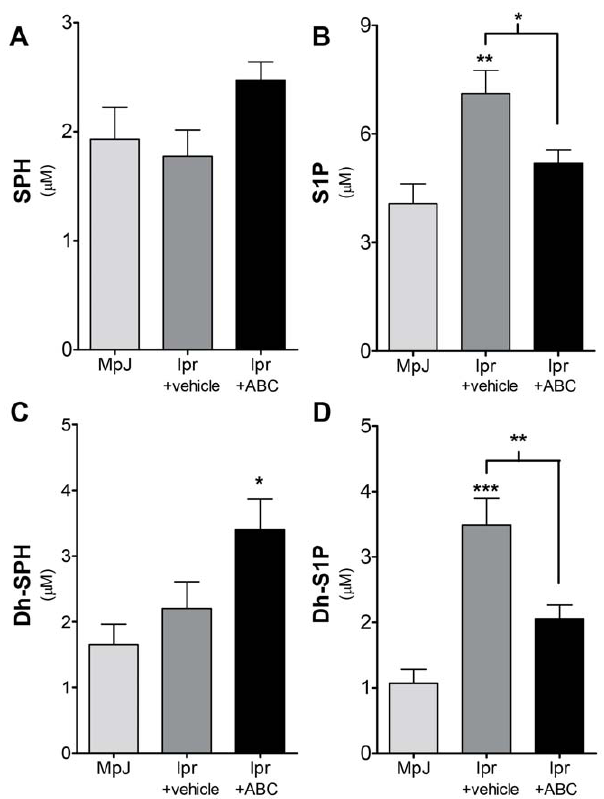
Figure 6. ABC294640 prevents accumulation of Dh-S1P and S1P in circulation of lupus mice. After 10 weeks of ABC294640 or vehicle administration, whole blood was collected from MRL/MpJ and MRL/lpr mice. Blood was analyzed for sphingolipid content by the Lipidomics Shared Resource at MUSC, A ) sphingosine, B ) S1P, C ) Dh- sphingosine and D ) Dh-S1P. Data represent mean 6 SEM, n $ 10; *p , 0.05, **p , 0.01, ***p , 0.001 treated vs. MPJ, unless otherwise